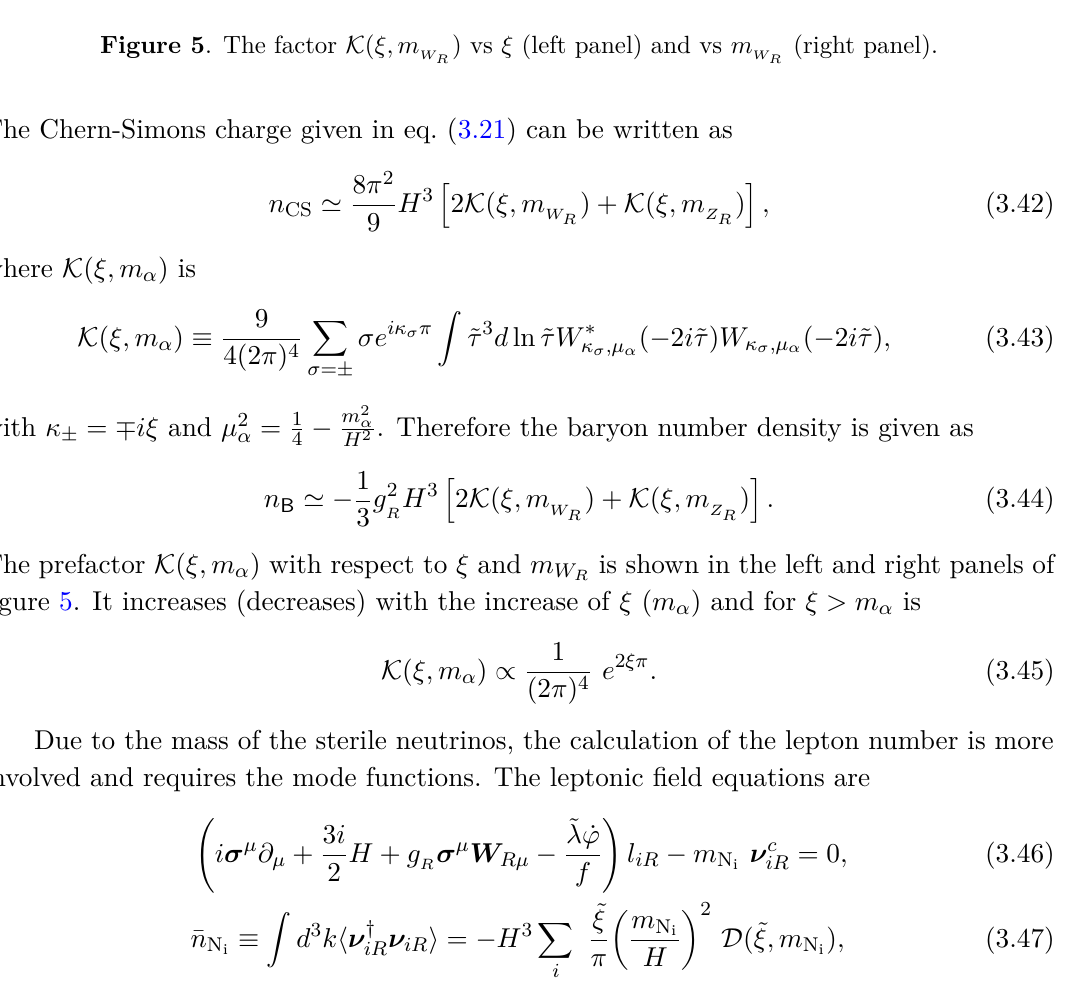
Figure 5 . The factor K ( ξ, m